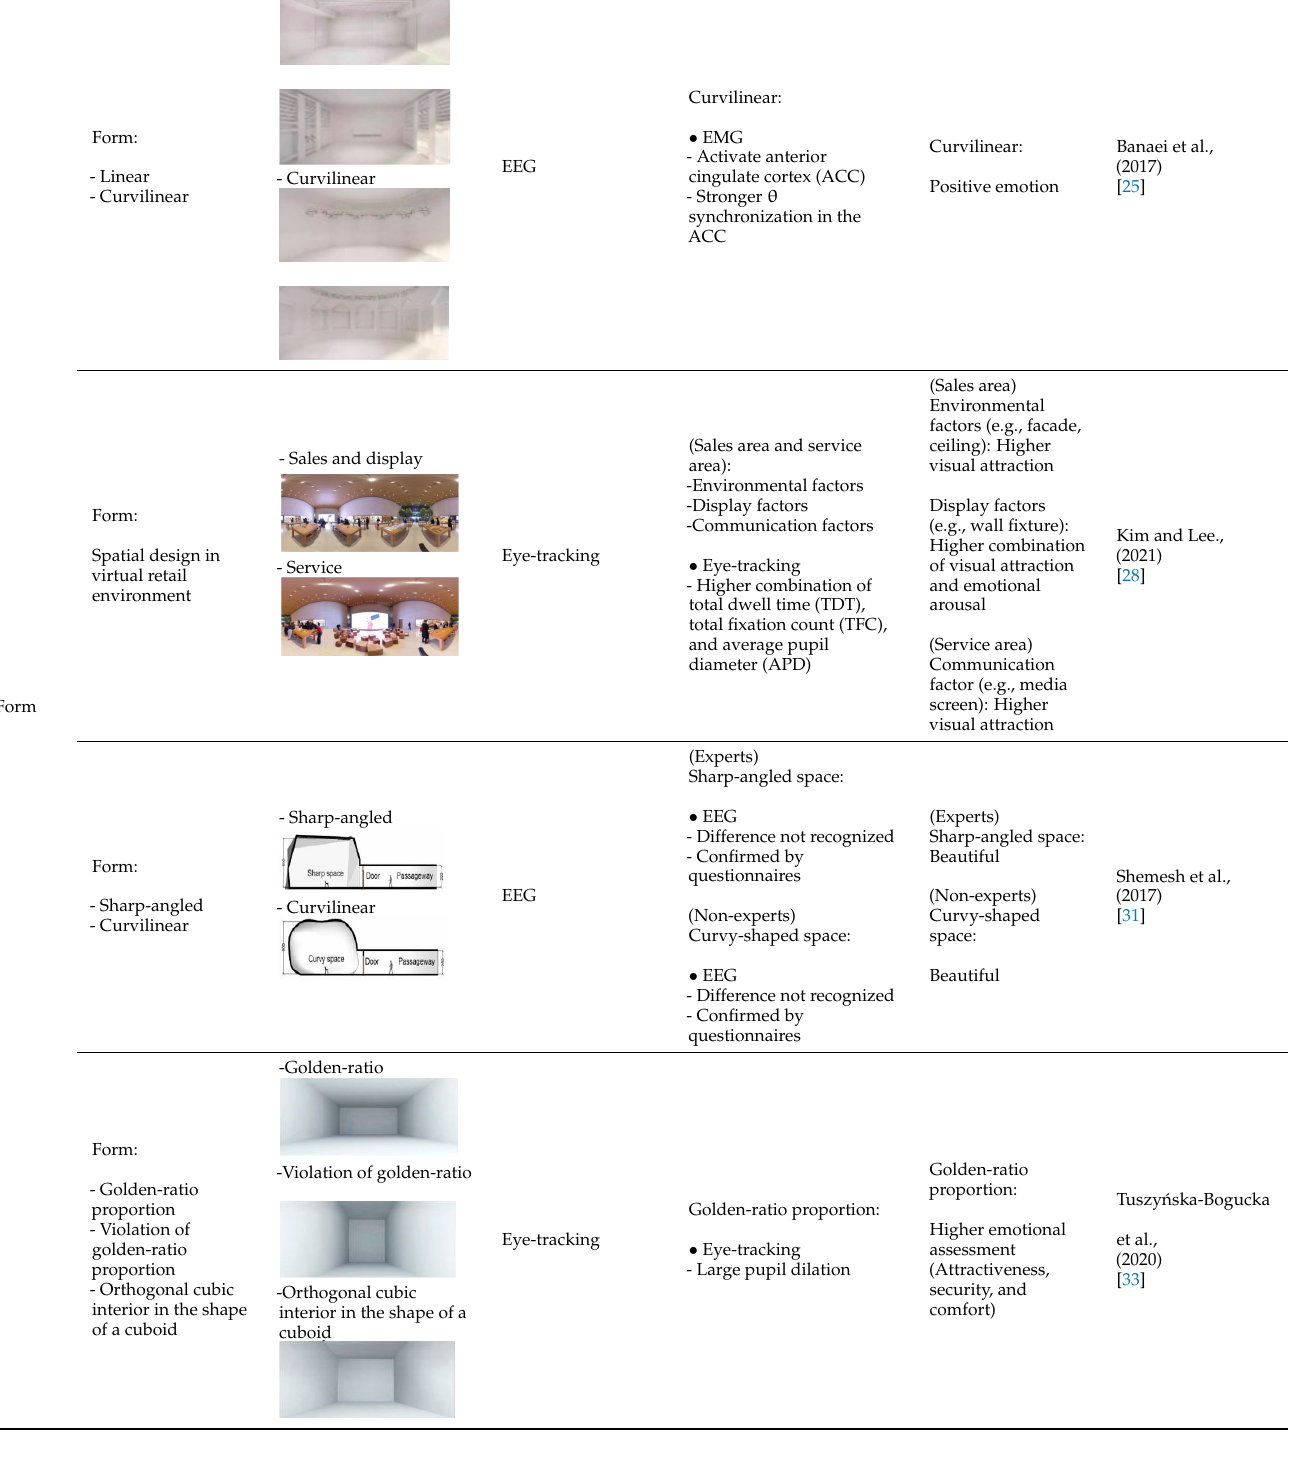
Golden-ratio proportion: Higher emotional assessment (Attractiveness, security, and